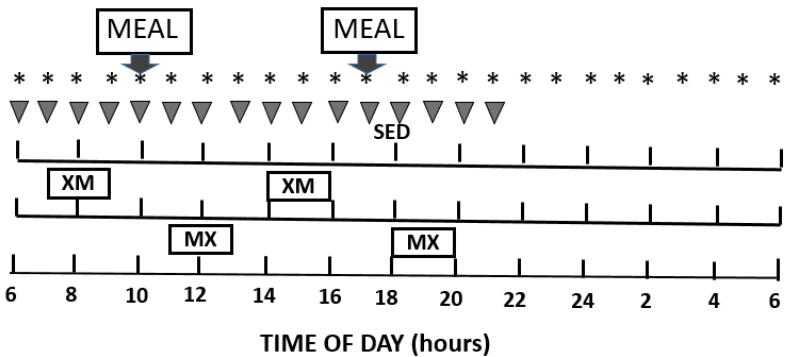
Figure 1. Study experimental design. Horizontal boxes show the sedentary group, timing of exercise before the meals (XM), exercise after the meals (MX) and the times of meals at 10:00 h and 17:00 h. Inverted triangles indicate times when the appetite measurements were taken on the visual analog scale (VAS). Asterisks (*) indicate hourly blood collection.